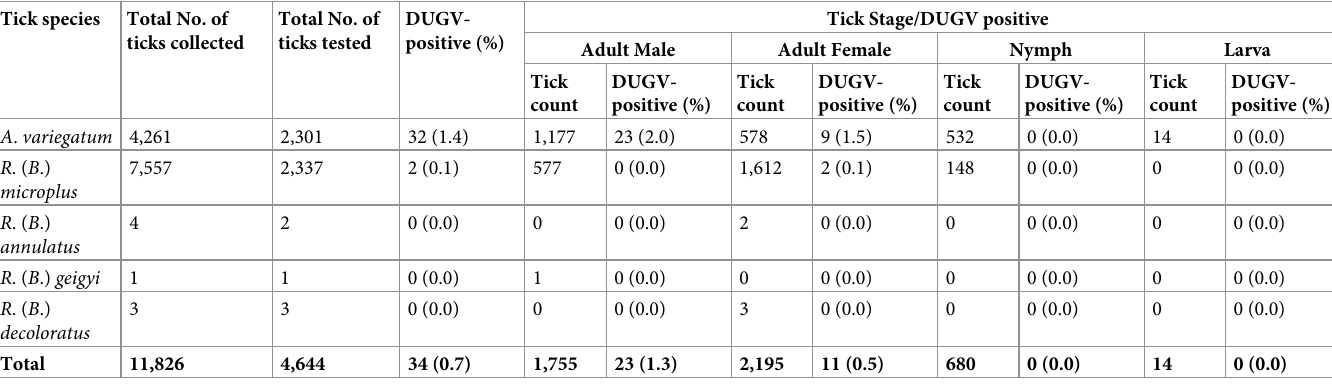
Table 2. Distribution of DUGV-positive ticks in Kwara State, Niger. Tick species Total No. of ticks